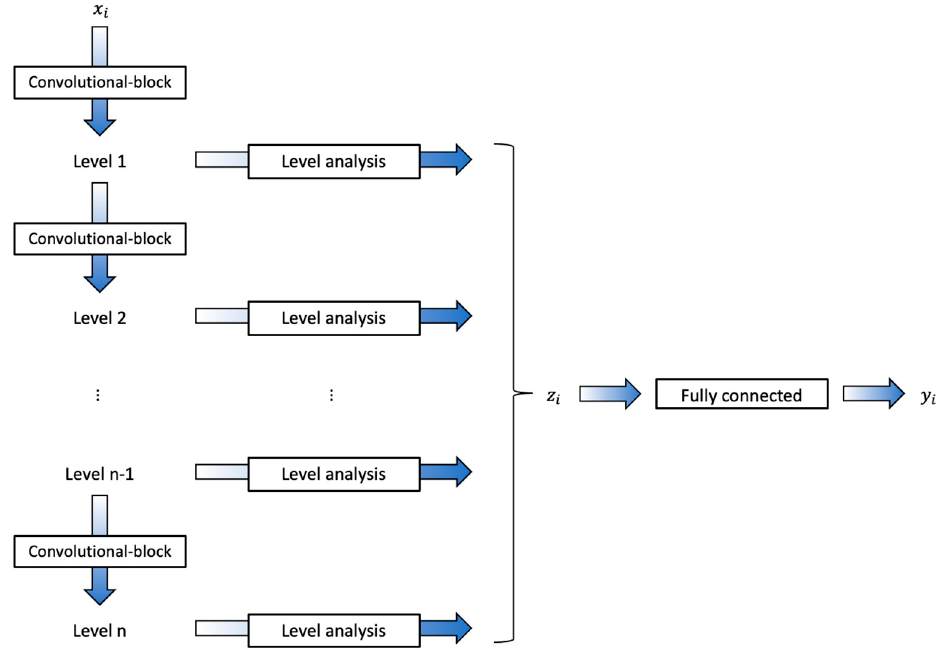
Figure A6. Overview of the encoder architecture. To the left, a series of convolutional blocks process and successively down-sample the data x i through max-pooling to produce levels of an increasing field of view. Each resulting level is analyzed further, and the results from all levels are concatenated to produce a latent representation z i of the data x i . A series of fully connected layers then produce the low-dimensional representation y i .